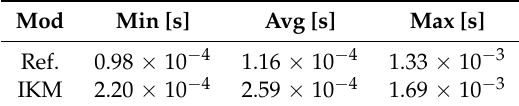
Table 6. Computation times of the PUMA’s IKM and its reference model (“Ref.” row), for all the points in the predetermined trajectory. Column “Avg [s]” presents the average computation times obtained during the trajectory’s execution (in seconds), while “Min [s]” and “Max [s]” show the minimum and maximum registered times,